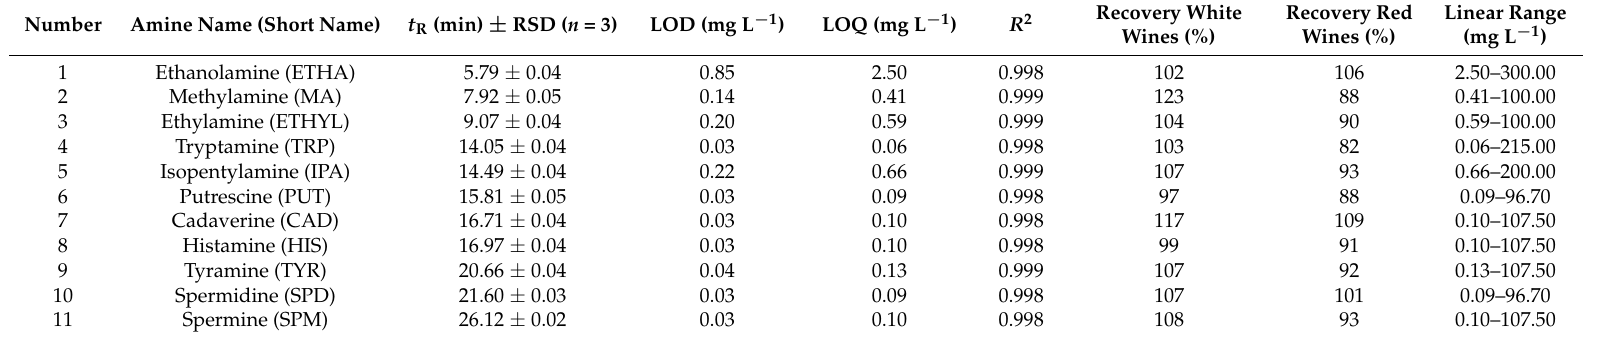
Table 4. The analytical parameters of a chromatographic method.